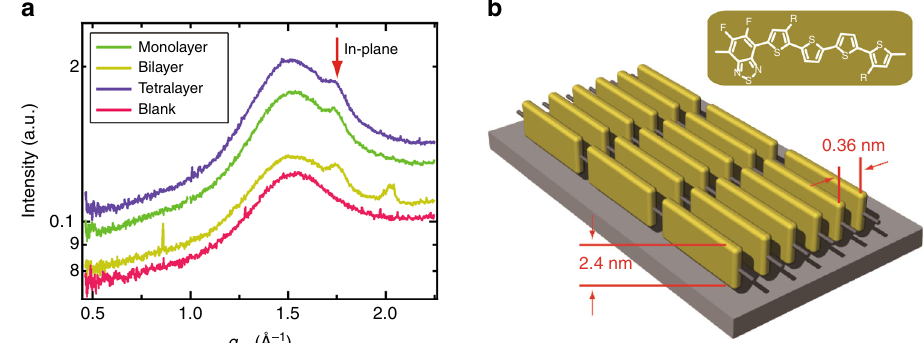
Fig. 2 Molecular order of PffBT4T-2DT monolayer. a In-plane GIWAXS line pro fi les. Pro fi les are offset for clarity. The in-plane (010) π – π peaks at q = 1.75 Å − 1 are indicated by red arrow. A bare substrate (blank) is also measured for reference (The feature at q ≈ 2 Å − 1 is parasitic scatter from Si dust). b Schematic illustration of a single nano fi ber of PffBT4T-2DT monolayer with an edge-on orientation, in which the brown bricks represent the monomer units of PffBT4T-2DT. The arrangement of backbones relative to each other is idealized. In reality, the monomers might not be in monolayer are 389 ± 138 nm in length and 48 ± 18 nm in width, with the coverage of 62%.